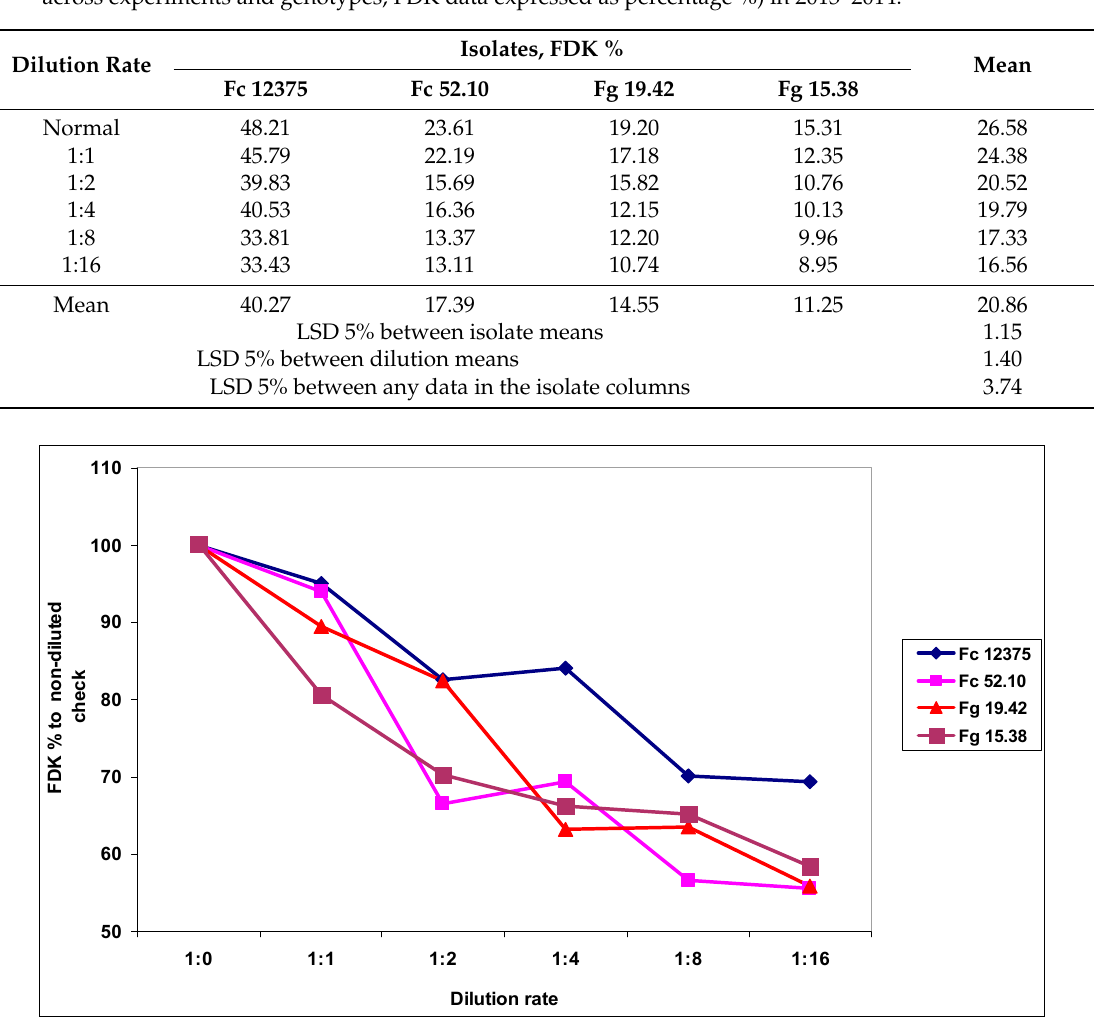
Figure 4. Reduction of the aggressiveness of F. graminearum and F. culmorum isolated at different dilution rates, FDK data, 100 = non-diluted inocula across genotypes, 100 = undiluted inoculum, used as check, 2013 and 2014.